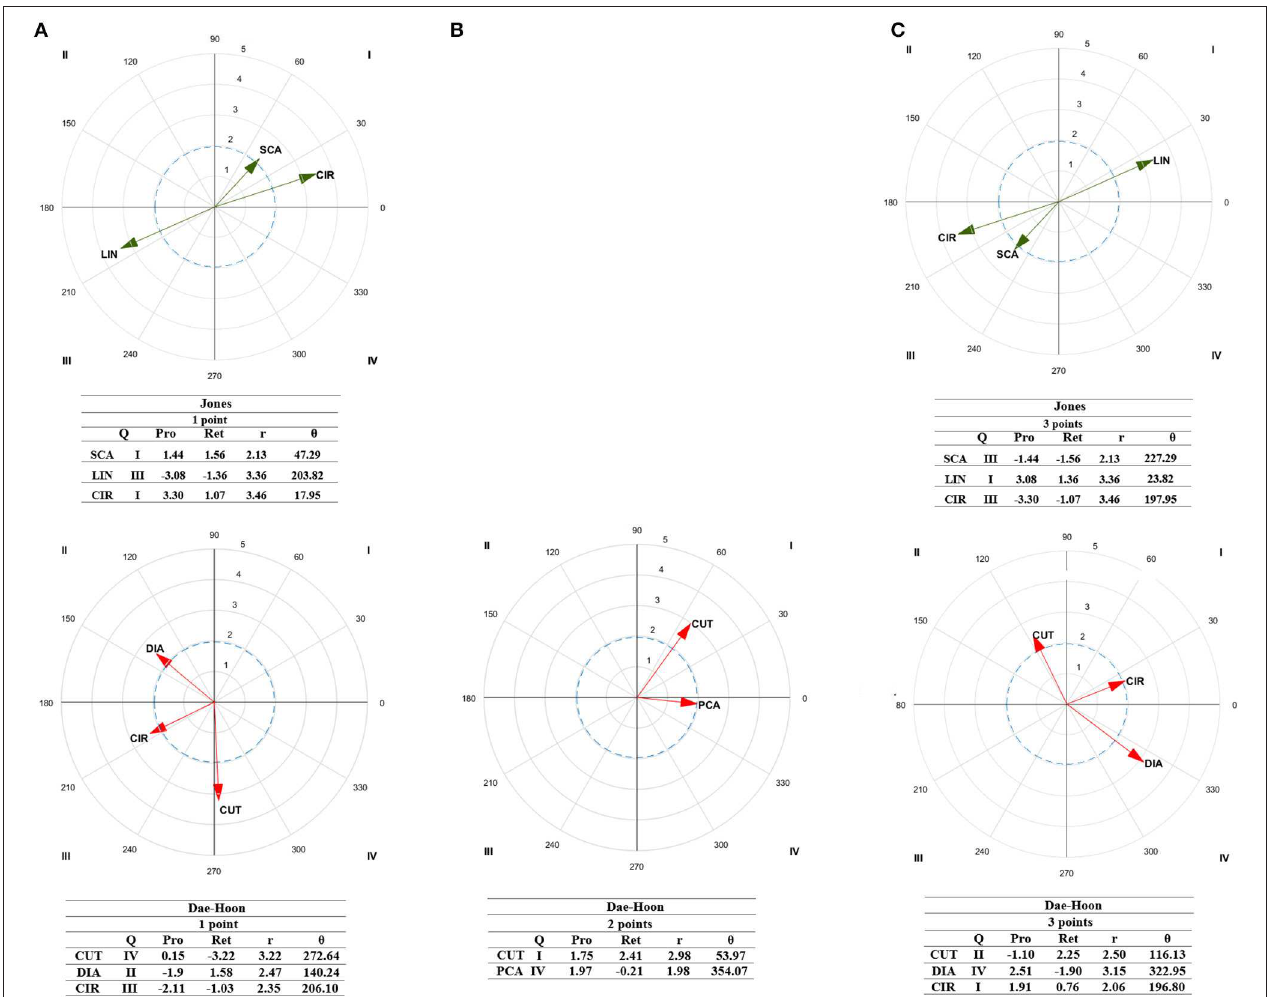
FIGURE 2 | Representation of behavioral maps for 1-point (A) , 2-point (B) , and 3-point (C) effective actions as focal behavior for Jones (green) and Dae-Hoon (red). The behavioral map was represented divided into four quadrants, with each of the conditioned categories as vectors in the axis X/Y and their respective coordinates Z sum prospective (X) and Z sum retrospective (Y). Significate vectors (Radium > 1.96), Zsum values, prospective (pros.) and retrospective (retr.) perspectives, quadrants (Q), radium length (r), and vector angle ( θ ) are represented. DOD, Dodges; CUT, Cuts; DIA, Direct Attack; PCA, Posterior Counterattack; LIN, linear technique; CIR, Circular